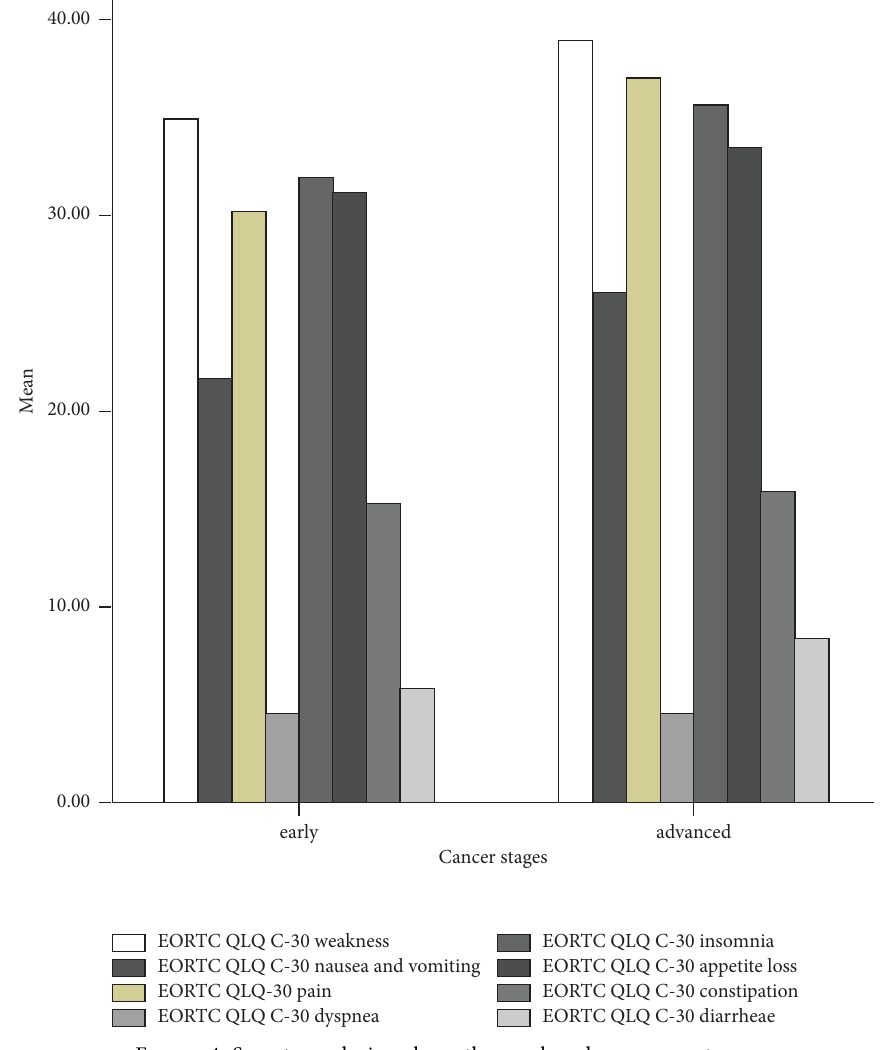
Figure 4: Symptoms during chemotherapy based on cancer